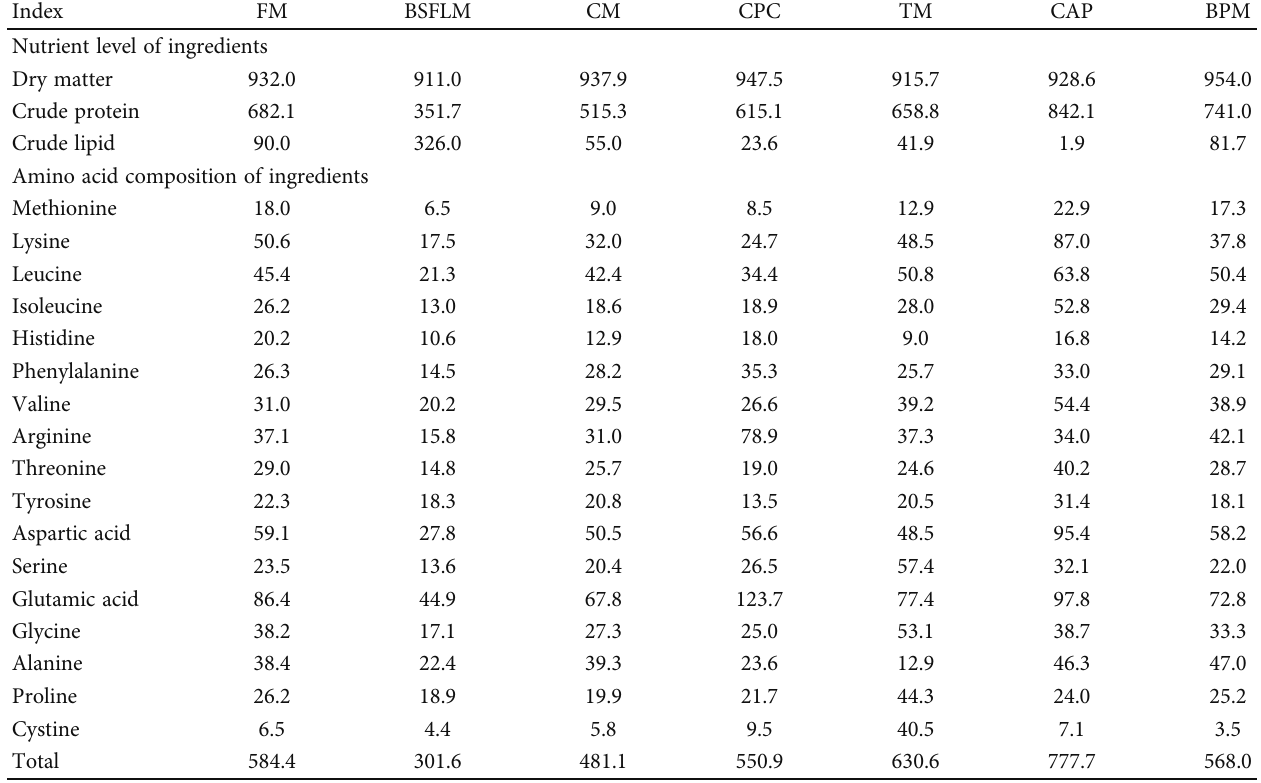
Table 2: Nutrient level and amino acid composition of test ingredients (g/kg dry matter).